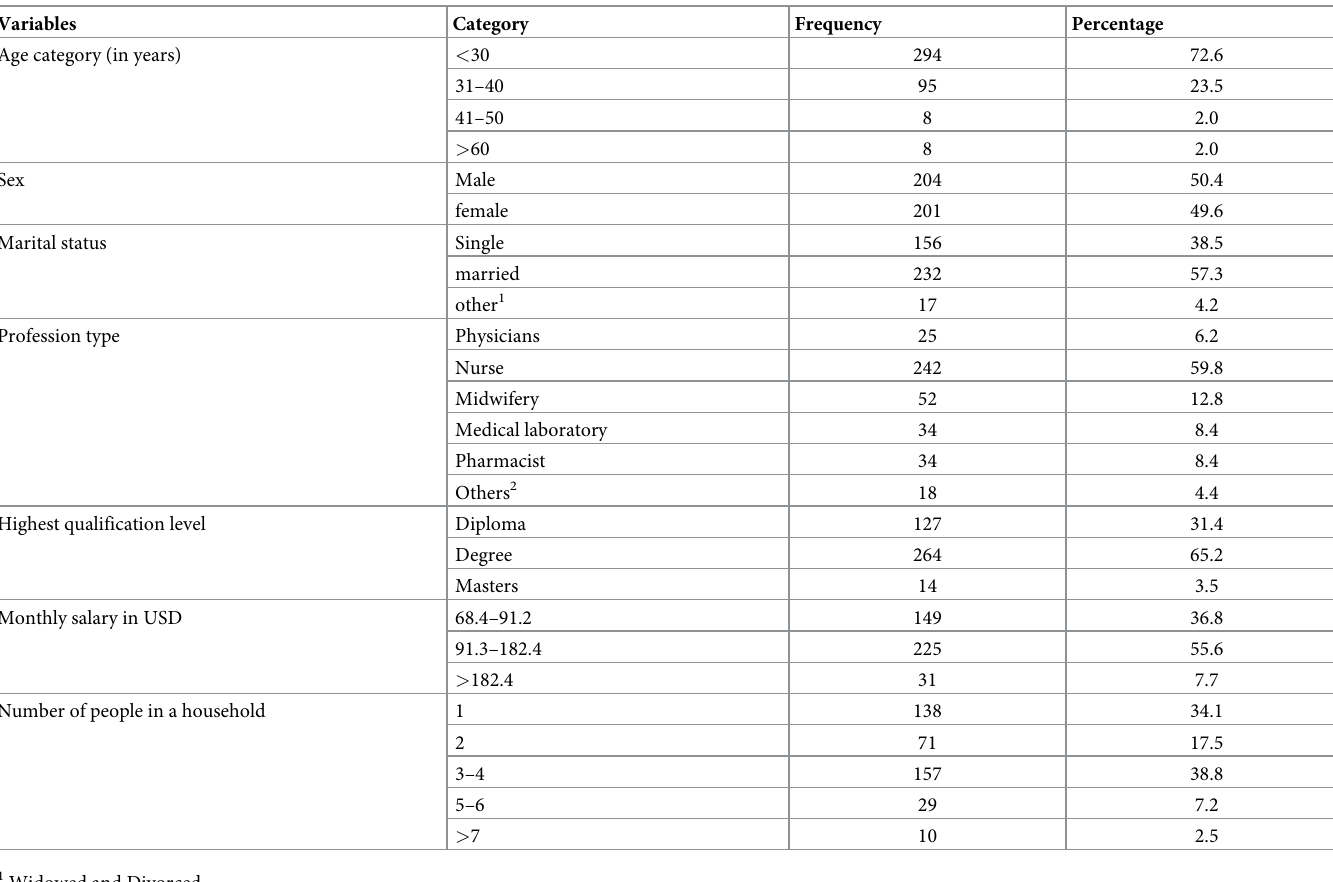
Table 1. Socio-demographic characteristics of the health care workers, hospitals of south western Ethiopia, 2021 (n = 405).